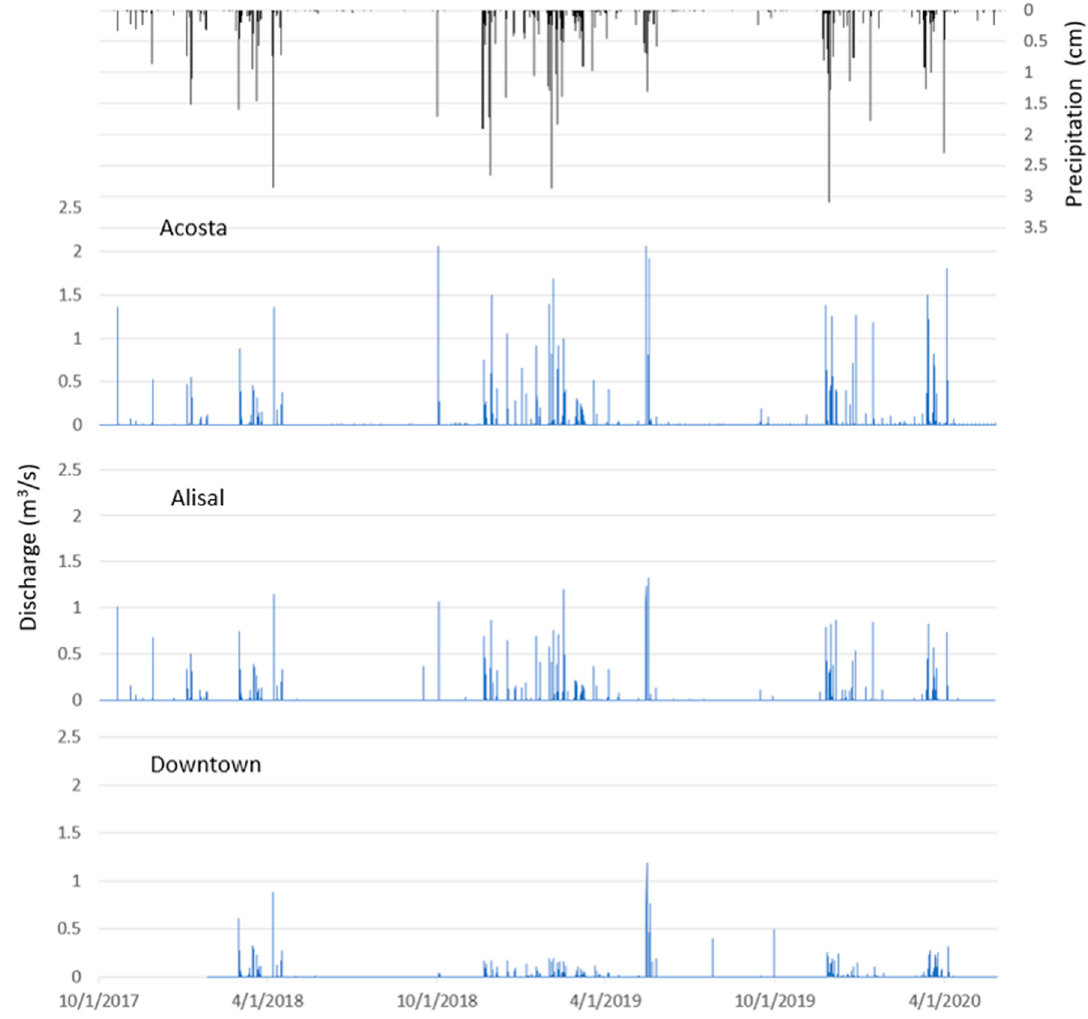
Figure 4. Rainfall and flow data collected at catchment outfalls during water years 2018–2020. Note that instrumentation was delayed in the Downtown catchment until January 2018.